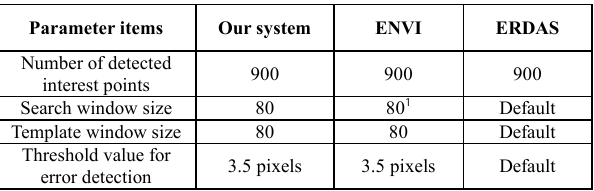
Table 3 Parameters used in all the